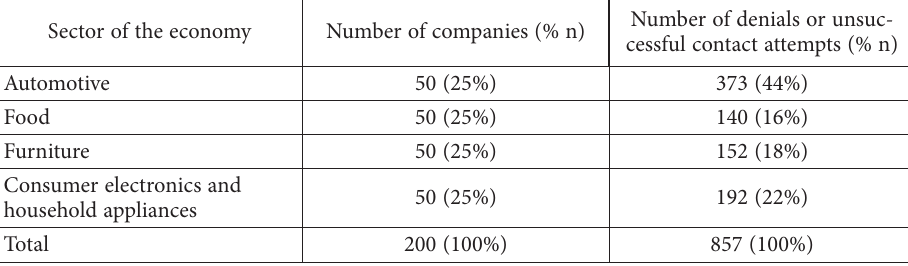
Table 1. Information according the research sample (n = 200) (source: elaborated by the authors) Sector of the